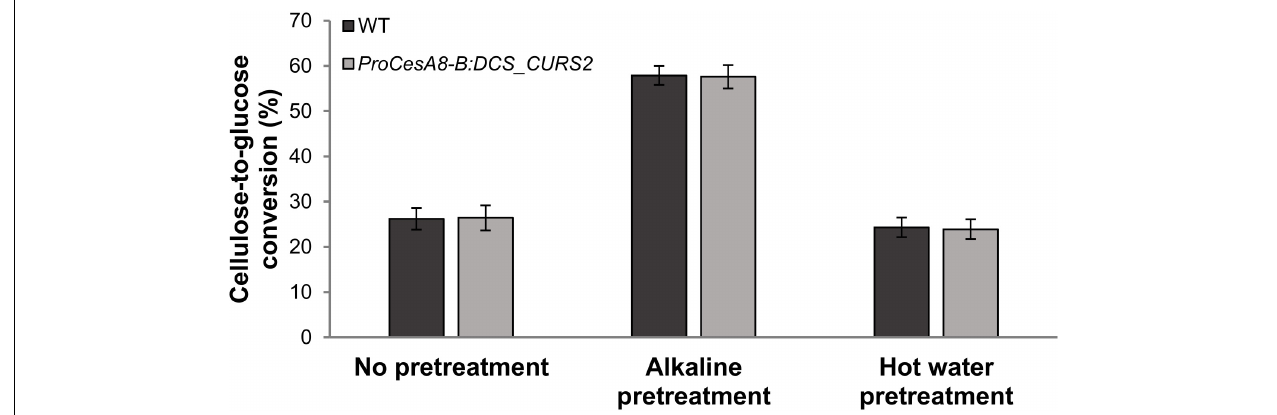
FIGURE 5 | Saccharification potential of stem biomass from WT and ProCesA8-B:DCS_CURS2 poplars. Cellulose-to-glucose conversion efficiency after 48 h of saccharification. Samples were saccharified using no pretreatment, alkaline pretreatment (62.5 mM NaOH, 3 h, 90 ◦ C) or hot water pretreatment (100% H 2 O, 3 h, 90 ◦ C). No significant differences between the WT and the transgenic lines were observed at the 0.01 significance level (Student’s t -test; WT, n = 8 biologically independent replicates; ProCesA8-B:DCS_CUR S2, n = 28 biologically independent lines). Error bars indicate standard